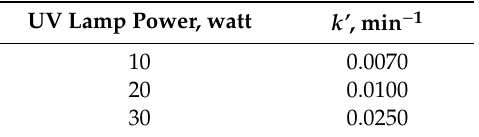
Figure 2. ( A ) Correlation of − ln(1 − x) and reaction time in UV lamp power variation. ( B ) Data fitted with a reaction model in the case of UV lamp power variation. Concentration of peroxide: 0.61 moles / L solution, pH 9. Table 1. Kinetic parameters as a function of UV lamp power